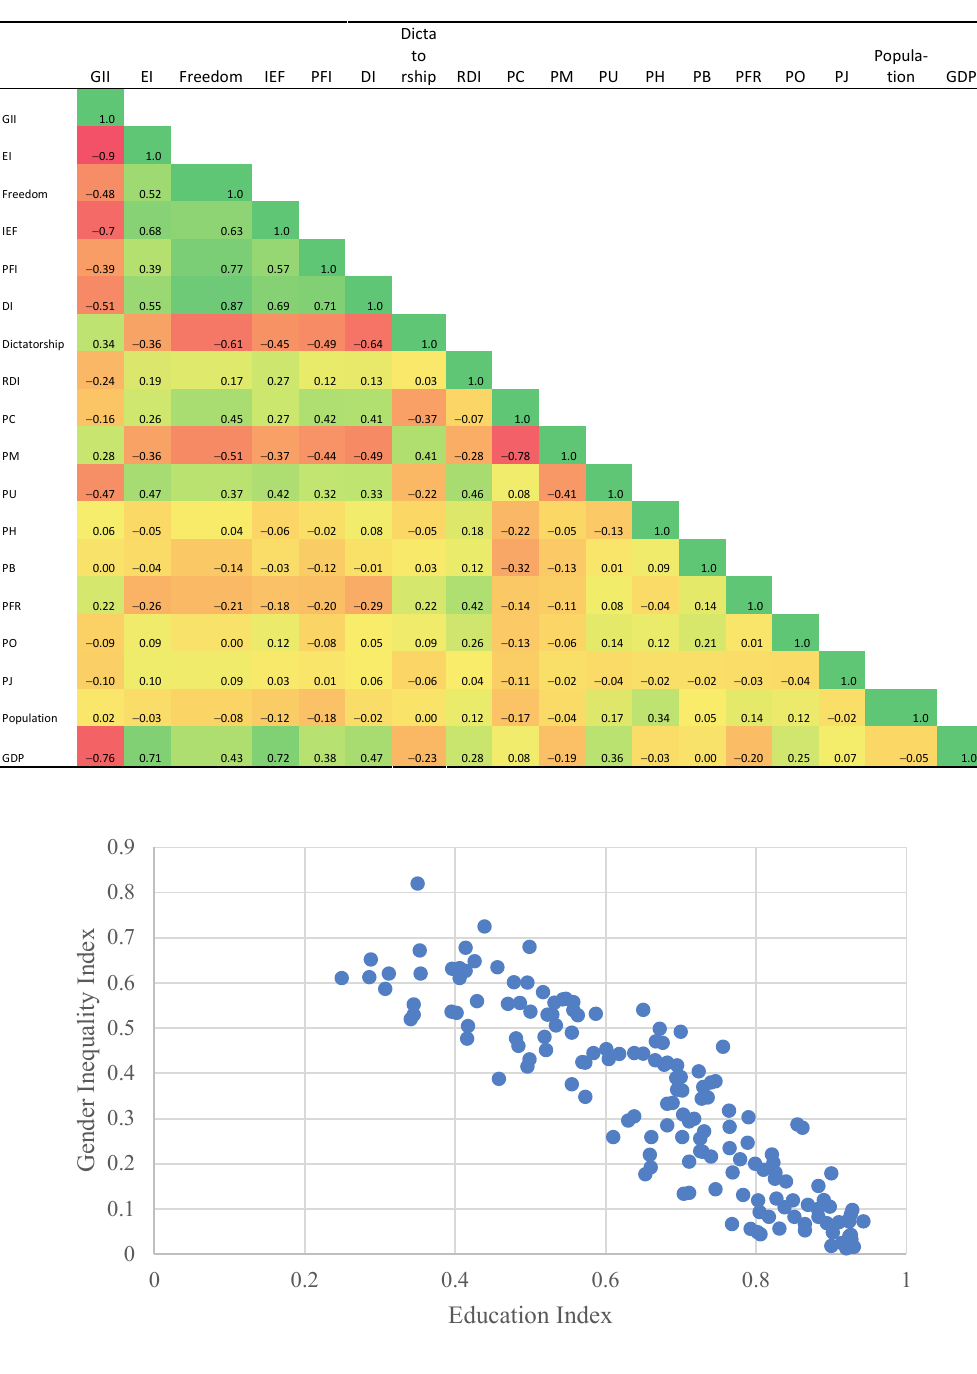
Fig. 2. Gender inequality index versus education